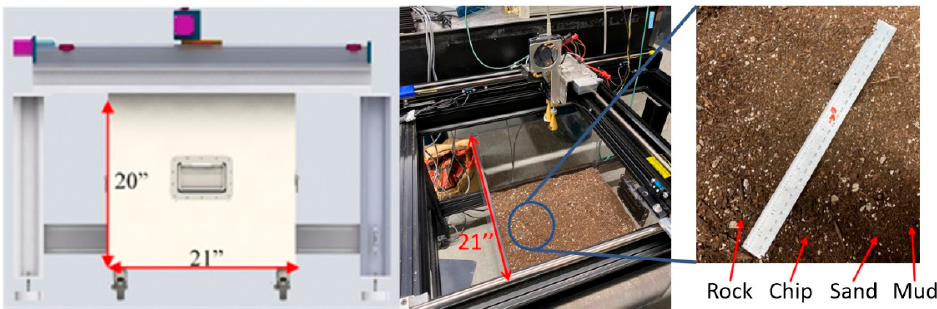
Figure 11. Underground imaging background material and its enclosure box.